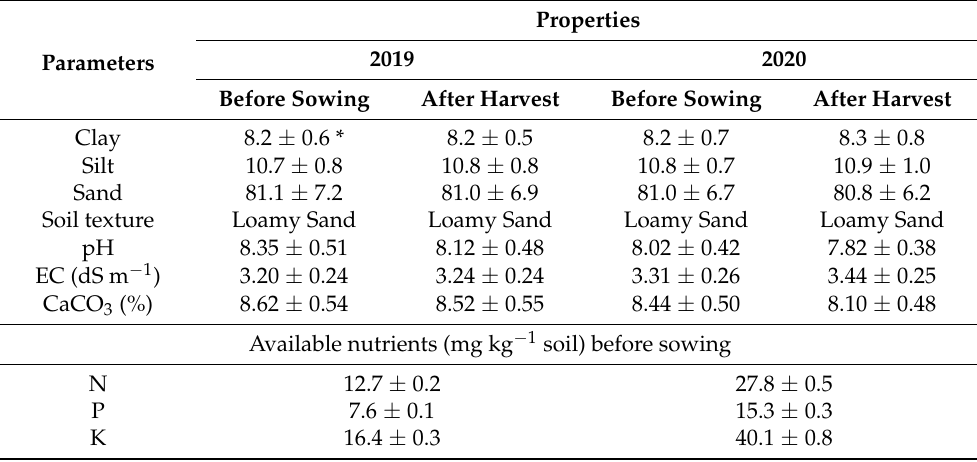
Table 2. The physicochemical properties of the tested soil before sowing and following and after harvest.